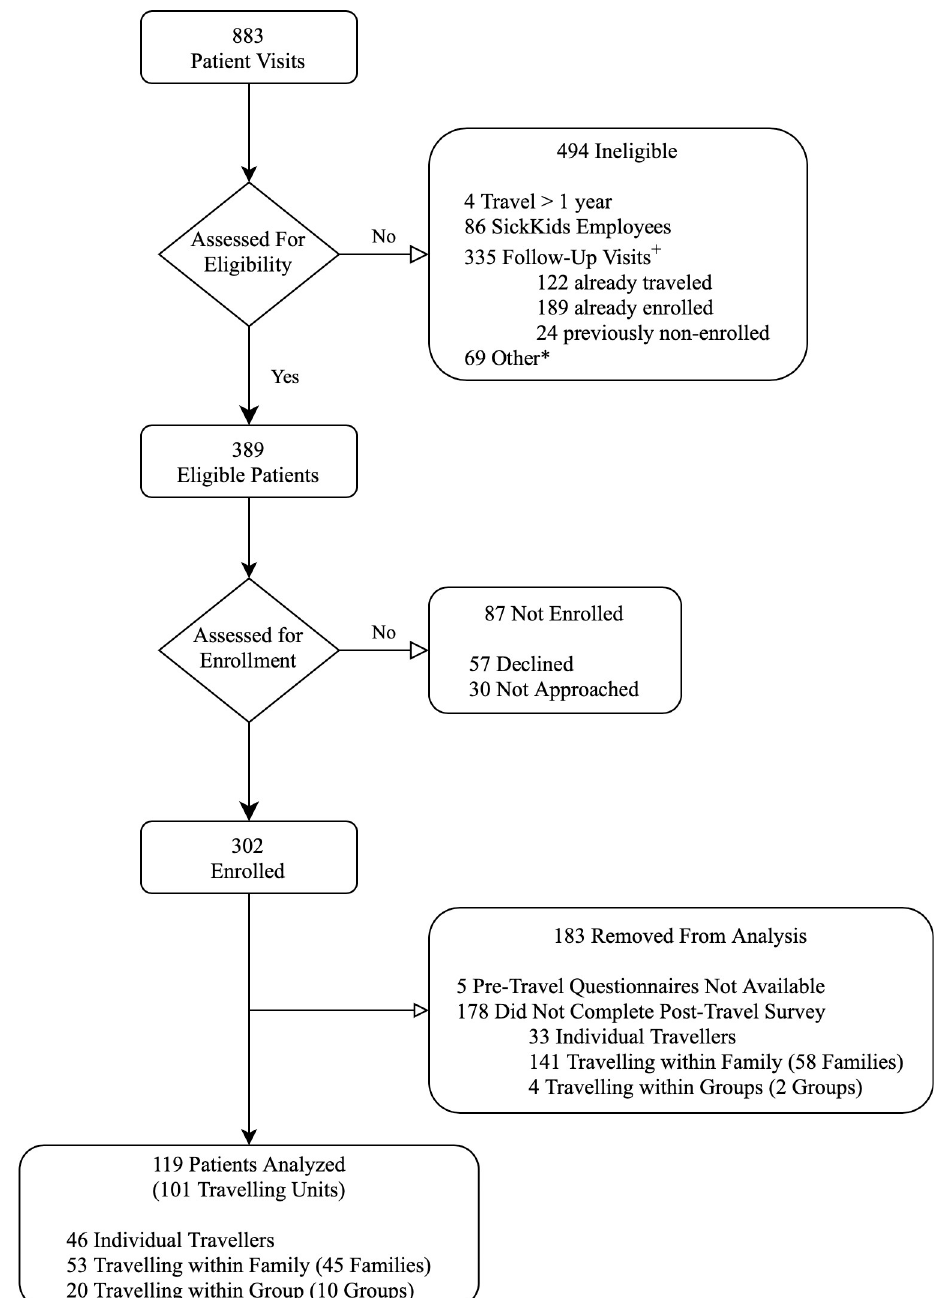
Fig 1. Included participants. + Follow-up visits included completion of multi-dose vaccine series. � Other–reasons for ineligibility not